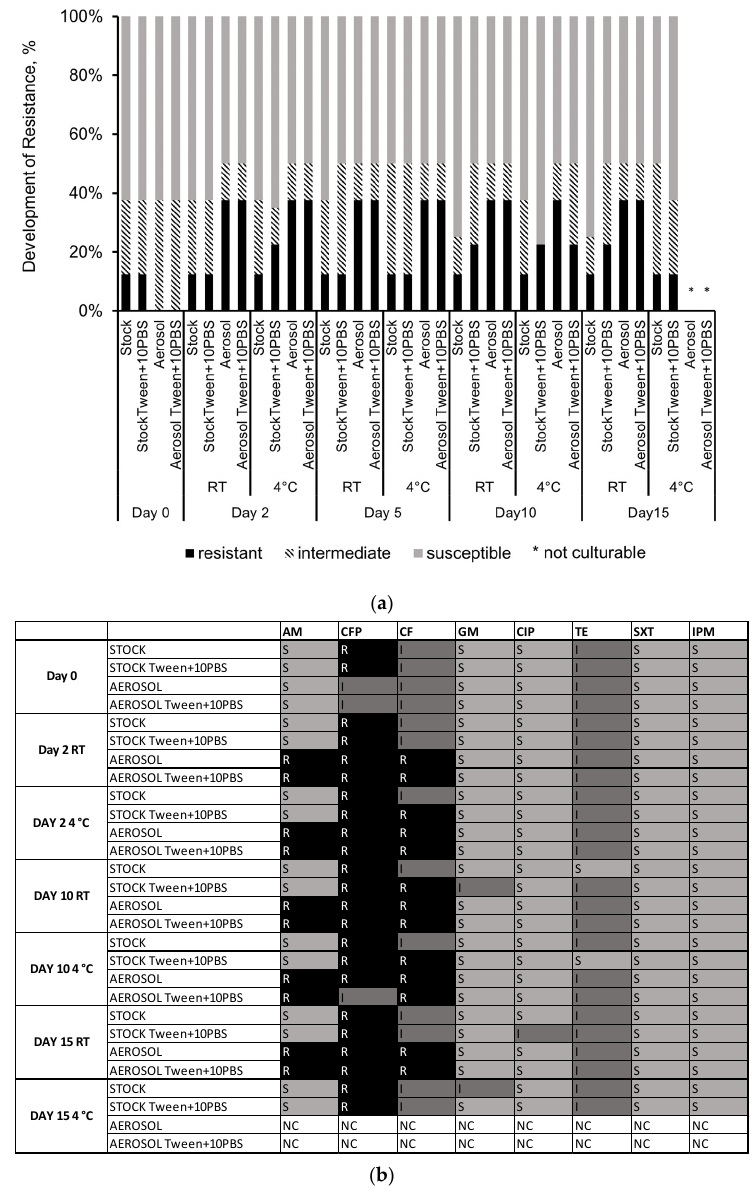
Figure 6. ( a ) The percentage of resistant, intermediate, and susceptible responses in each sample archived at either 4 °C or RT as collected with Tween-20 (Tween) or collected with Tween and amended with PBS (Tween + 10PBS) were recorded over a 15-day period. Samples that were not culturable are denoted by an asterisk. ( b ) Heat map showing Resistant (black), Intermediate (dark grey), Susceptible (light grey) or Not Culturable (white) responses to the Kirby–Bauer susceptibility test antibiotics (Ampicillin (AM), Cefoperazone (CFP), Cephalothin (CF), Gentamicin (GM), Ciprofloxacin (CIP), Tetracycline (TE), Sulfamethoxazole trimethoprim (SXT) and Imipenem (IPM)). Stock E. coli (S), nebulized liquid (N) and collected aerosol (A) sample.